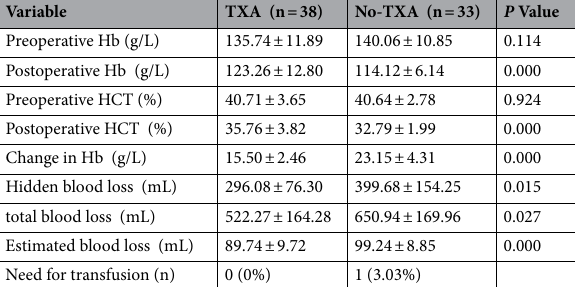
Table 3. Blood loss of all